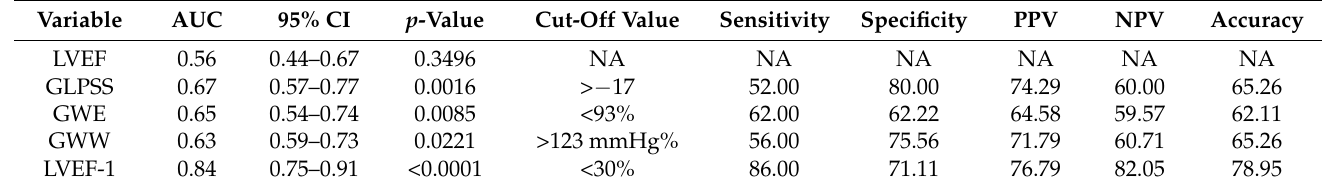
Table 5. AUC for standard (LVEF and GLPSS) and newer (GWW, GWE, and LVEF-1) LV systolic function indices to differentiate CAD patients from healthy controls.